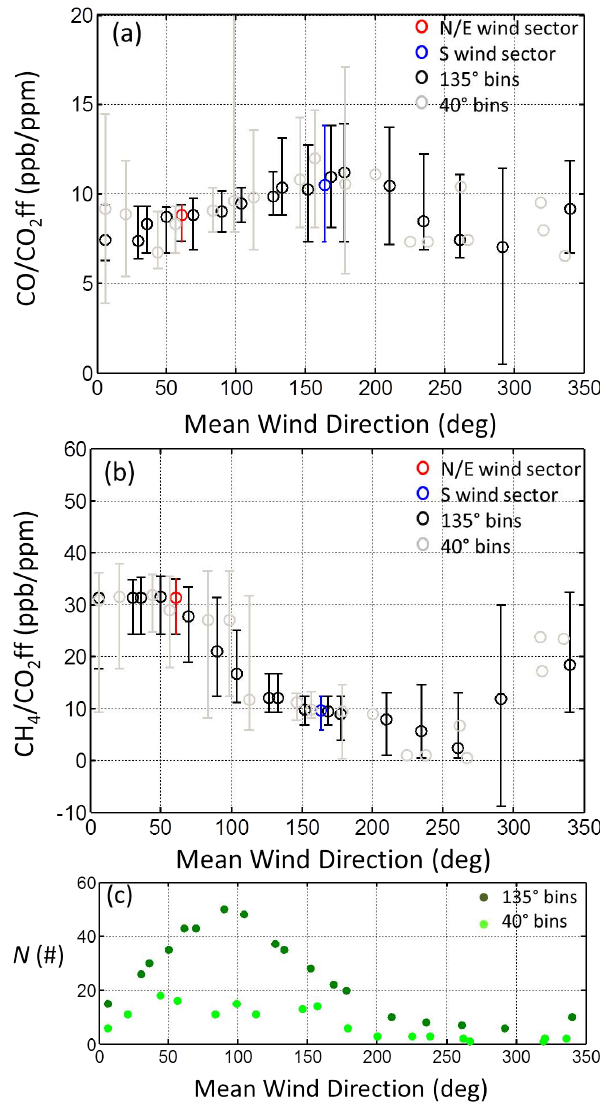
Fig. 3. Tracer/CO 2 ff ratios as a function of mean wind direction for (a) CO and (b) CH 4 for each rotating 135 ◦ -wide and 40 ◦ -wide wind sector wedge. The number of observations in each 135 ◦ and 40 ◦ wedge is shown in (c) . Also shown are the tracer/CO 2 ff ratios calculated for the N/E (red) and S (blue) wind sectors used in the